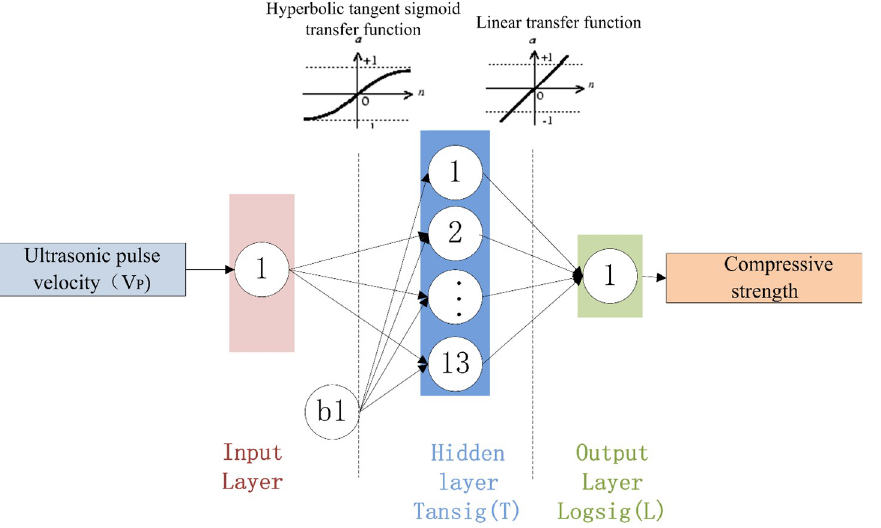
Fig 18. Optimal BPNN structure with one input parameter (V P